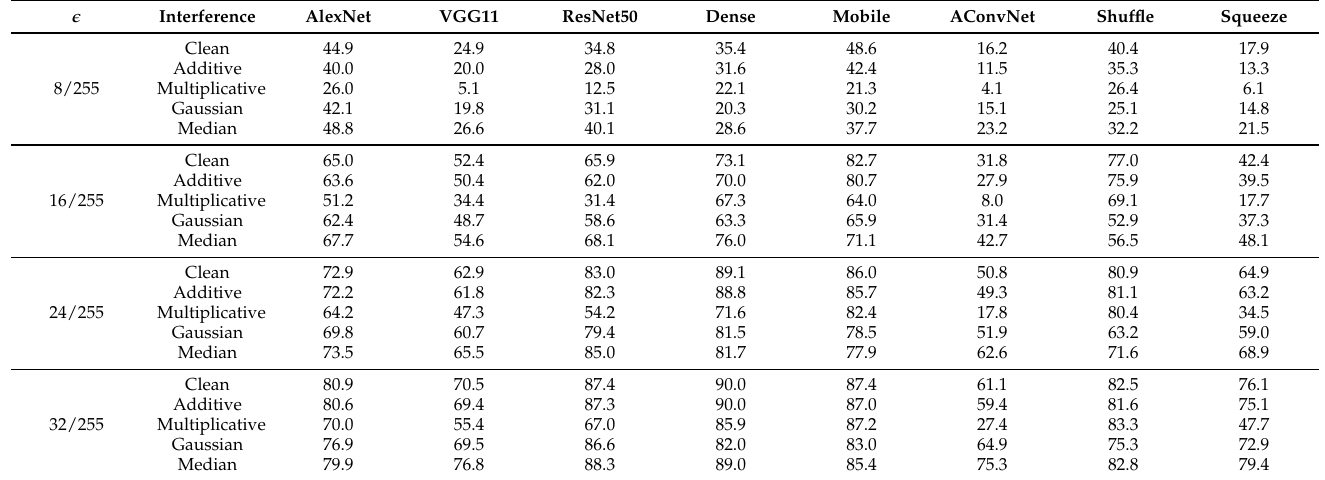
Table A4. Robustness test of of GD-UAP with VGG11 as substitute model.